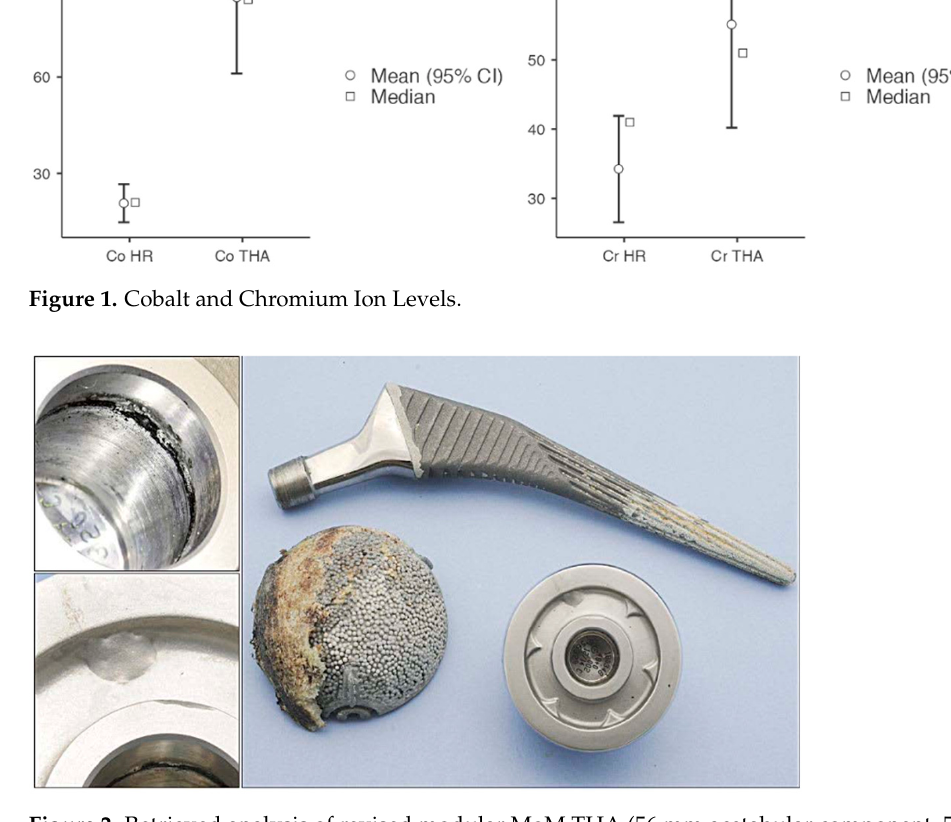
Figure 2. Retrieved analysis of revised modular MoM THA (56 mm acetabular component, 50 mm femoral head). (Picture from original publication on same patient series, Plant et al [20])